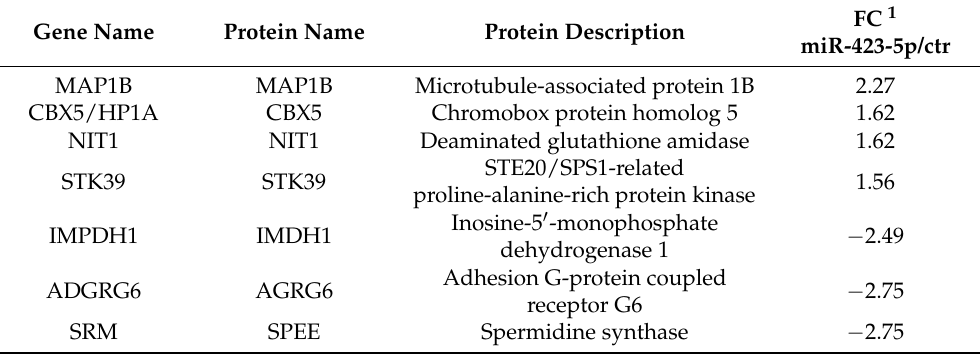
Figure 4. Summary of target genes of hsa-miR-423-5p (miTGs). ( A ) Venn diagram to identify common targets predicted by DIANA microT-CDS, TargetScan_Human_v8.0, mirDIP, and mirDB. ( B ) Venn diagram showing the targets commonly represented between DEPs and predicted miTGs. Table 6. Predicted target genes of hsa-miR-423-5p (miTGs) and corresponding proteins modulated by the overexpression of miR-423-5p in LNCaP